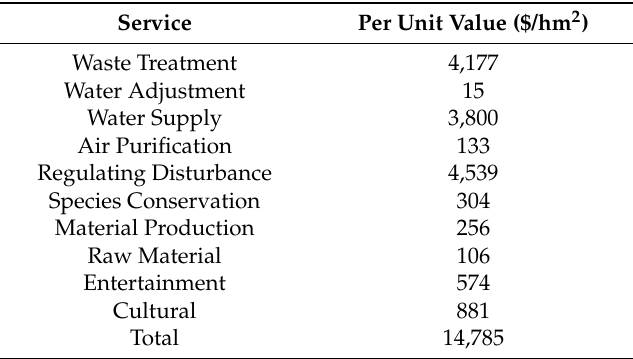
Table 3. The value of ecosystem services of global